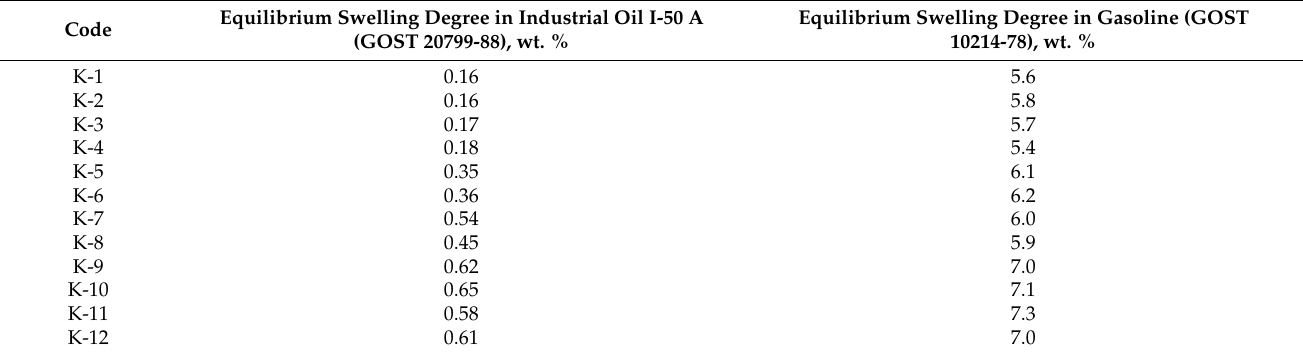
Table 7. Equilibrium swelling degree of the synthesized samples in industrial oil and